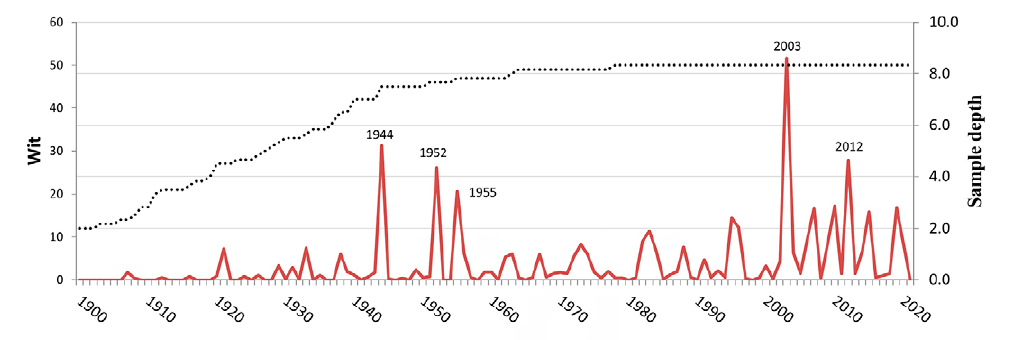
Figure 9. Histogram showing the semi-quantitative W